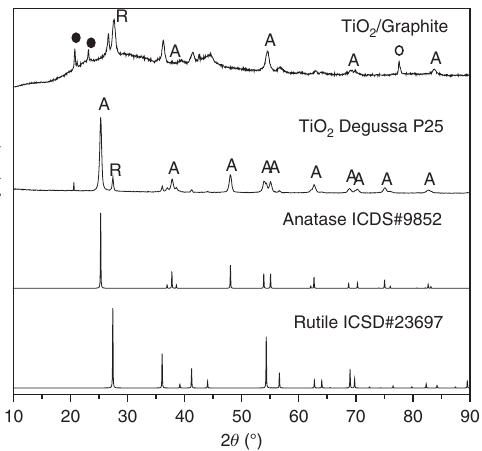
/G, which was synthesized by the Figure 1: XRD pattern of TiO 2 chemical bath deposition method and the TiO P25 Degussa powder 2 in comparison with standard rutile ICSD 23697 and anatase ICSD 9852. R refers to rutile, A refers to anatase, • is indicated as CTAB, and ○ is indicated as graphite